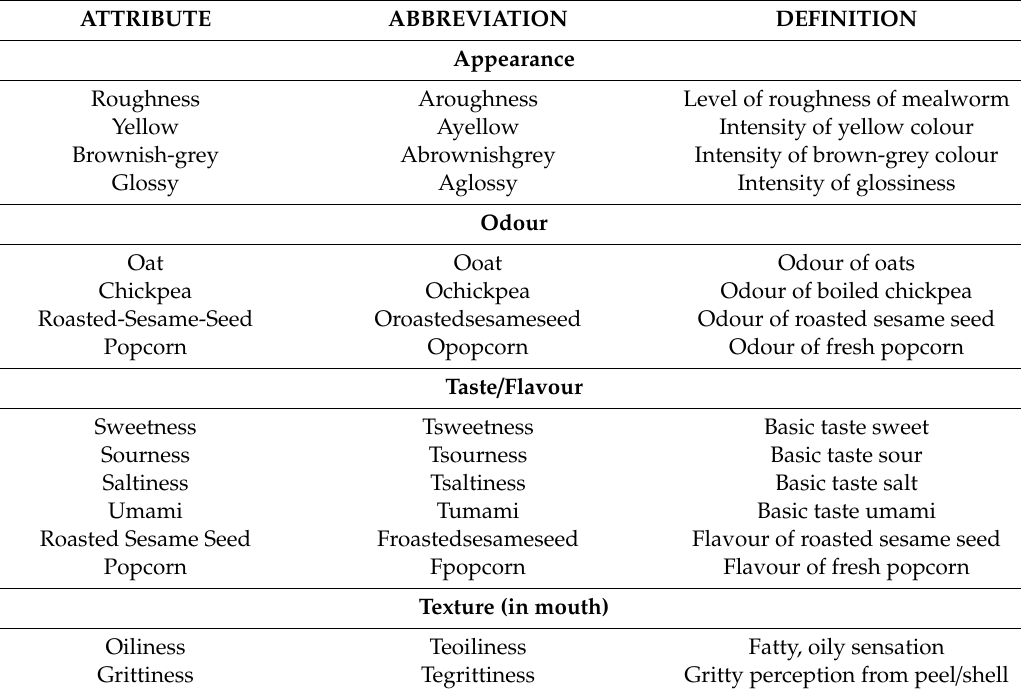
Table 4. Sensory attributes and their